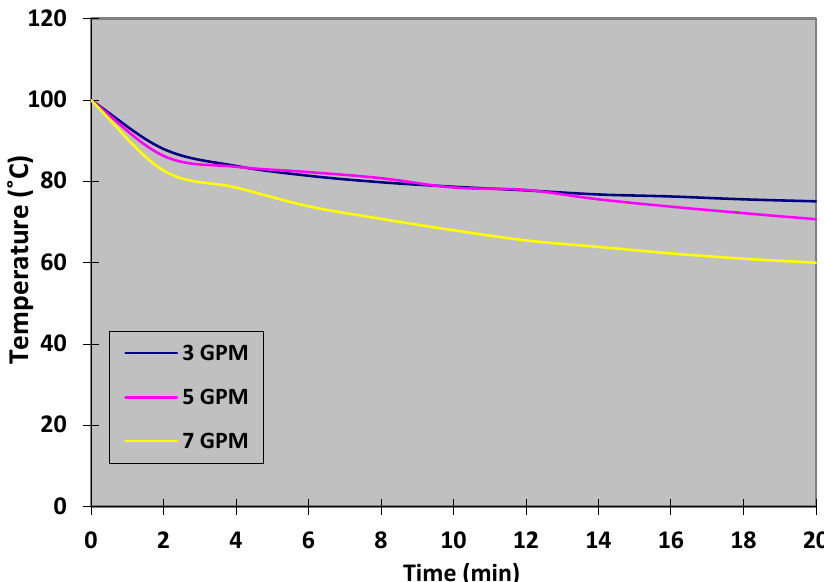
Figure 9. Surface temperature for 25% of distilled water mixed with 75% of ethylene glycol.